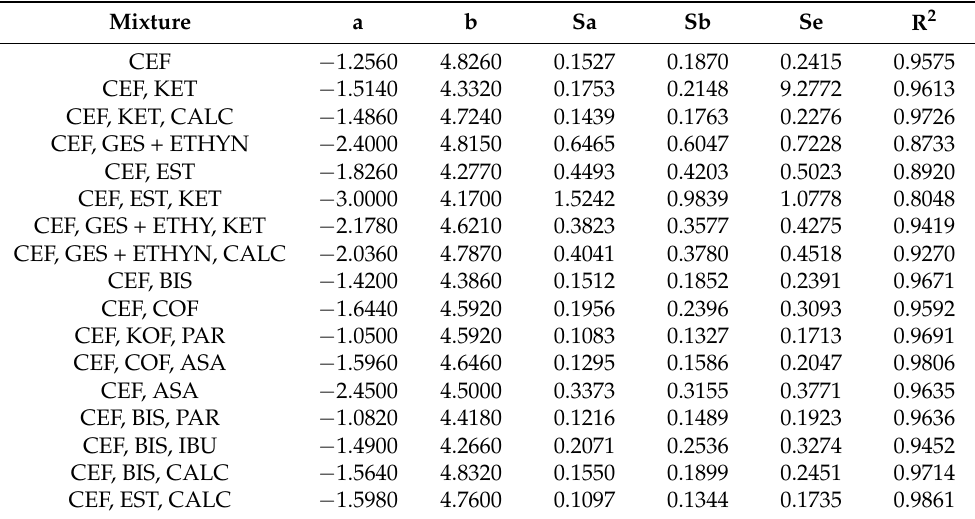
Table 6. Statistical parameters of calibration curves of cefepime in the tested drug mixtures after UV radiation.